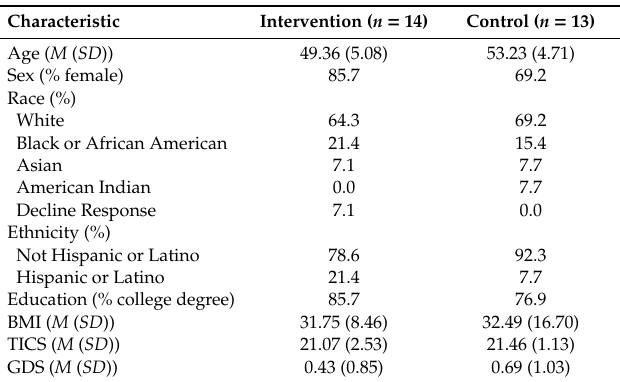
Table 1. Demographic characteristics ( N =